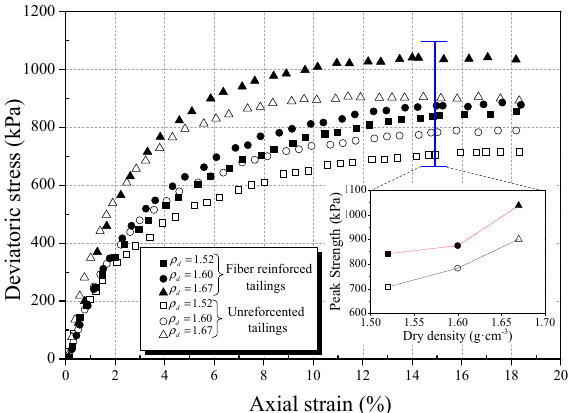
Figure 11. Effect of dry density on mechanical behavior of reinforced tailings silt (0.4 wt% fiber content).